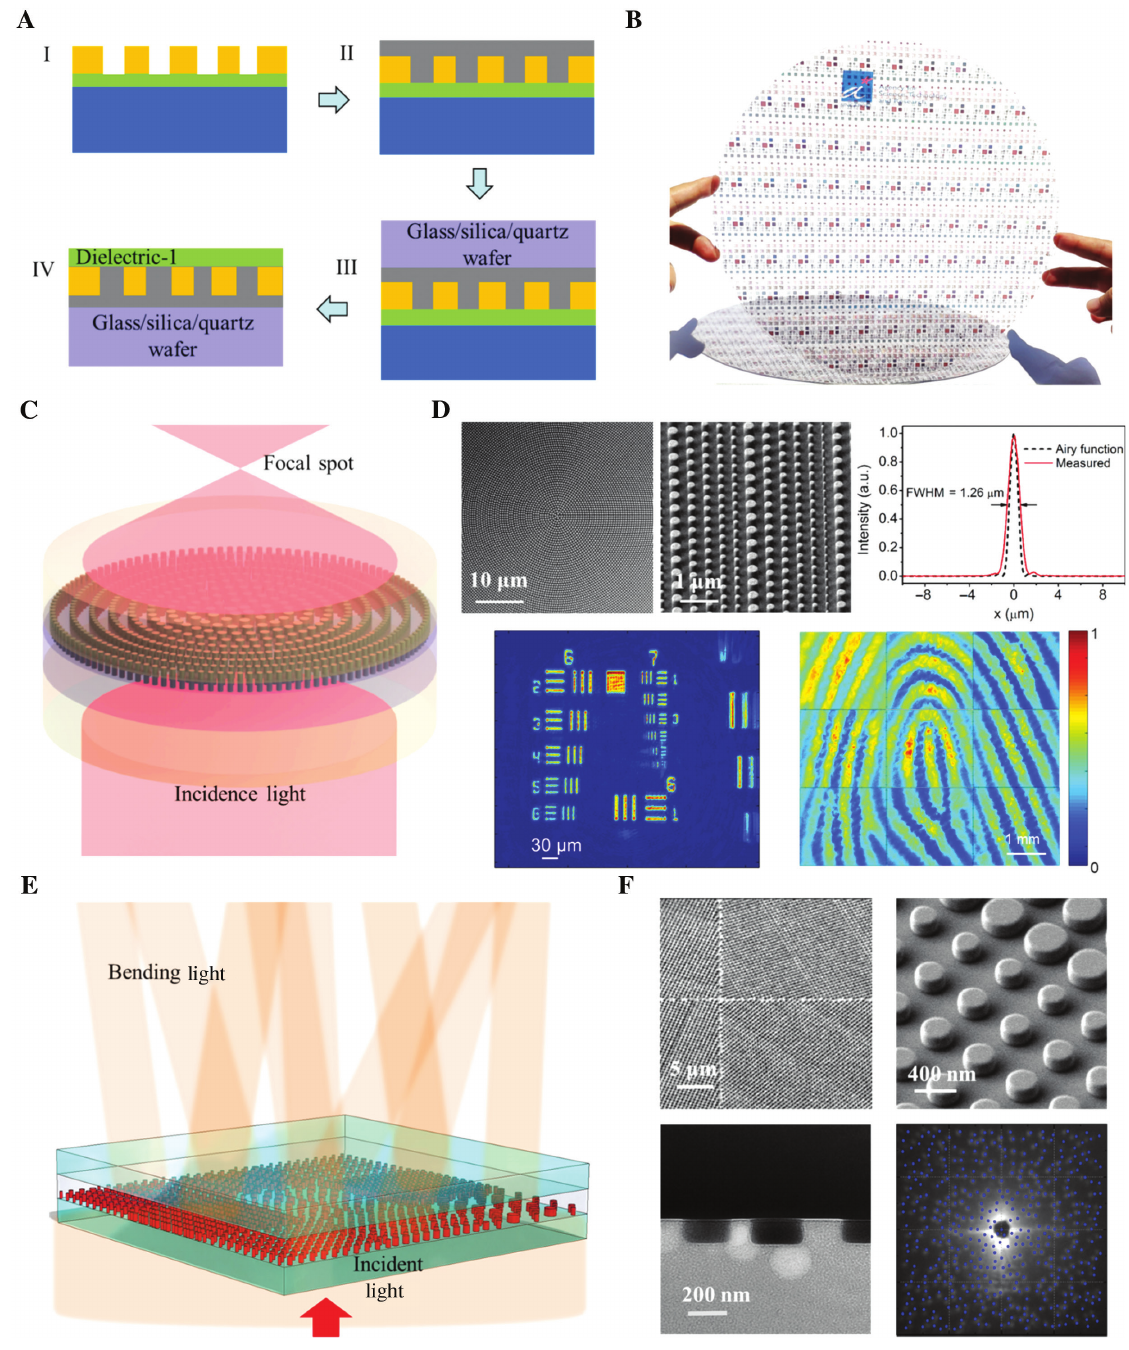
Figure 6: Metasurface-based devices demonstrated on 12-inch glass wafer using immersion scanner and layer transfer process. (A) Fabrication process flow to transfer metasurface layer on glass wafer. (B) Fabricated 12-inch glass wafer. (C) Schematic of metalens on 12-inch glass wafer. (D) Top-view (top left) and projected zoomed-in view (top middle) SEM images of the nanopillars with a height of 600 nm designed for metalens; intensity profile at the focal spot with an Airy function overlaid (top right); optical image of the 1951 USAF resolution chart formed using the metalens (bottom left); and fingerprint image formed using the metalens, proving the concept of metalens array for better imaging quality and compact system (bottom right). (B–D) Adapted with permission from [67]. (E) Schematic of pixelated deflector array on 12-inch glass wafer. (F) Projected-view SEM image of the pixelated deflector array showing the boundary between the pixels clearly (top left); projected zoomed-in view SEM image of the nanopillars for deflector array, with a pillar height of 100 nm (top right); TEM image of the nanopillar embedded in bonding glue (bottom left); and random spots (white dots) generated by the deflector array overlapping with the design (blue spots), showing a good match (bottom right). (E and F) Reprinted with permission from